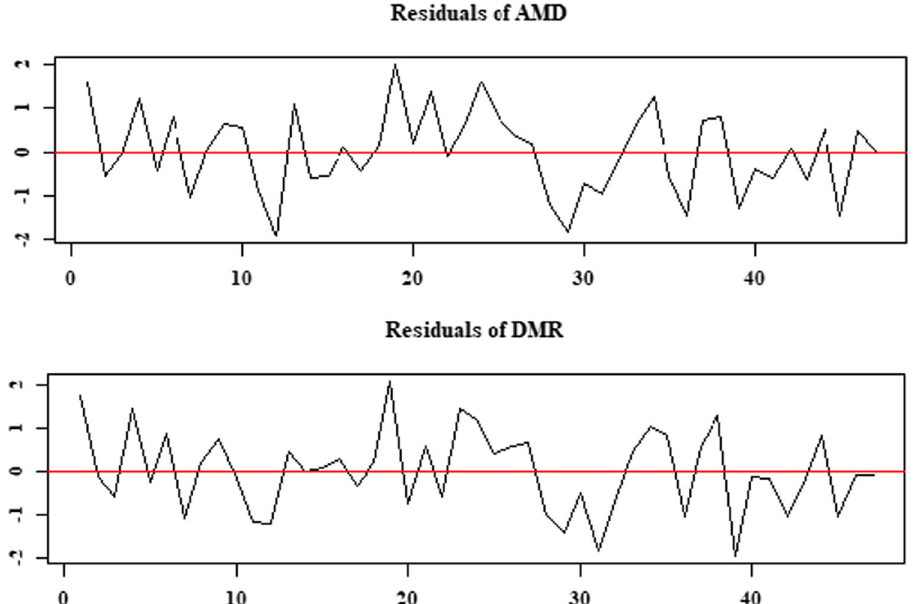
Fig. 3 Residuals series of AMD and DMR